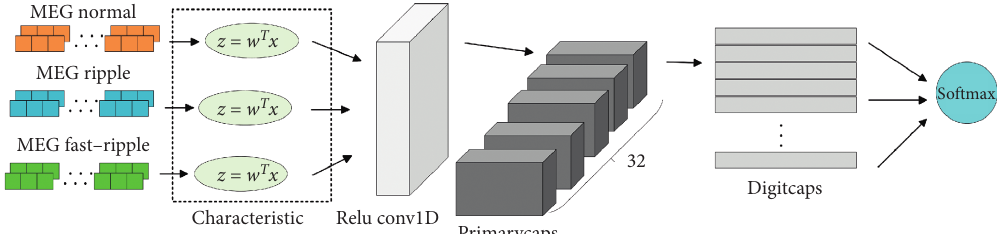
Figure 2: MEGNet network